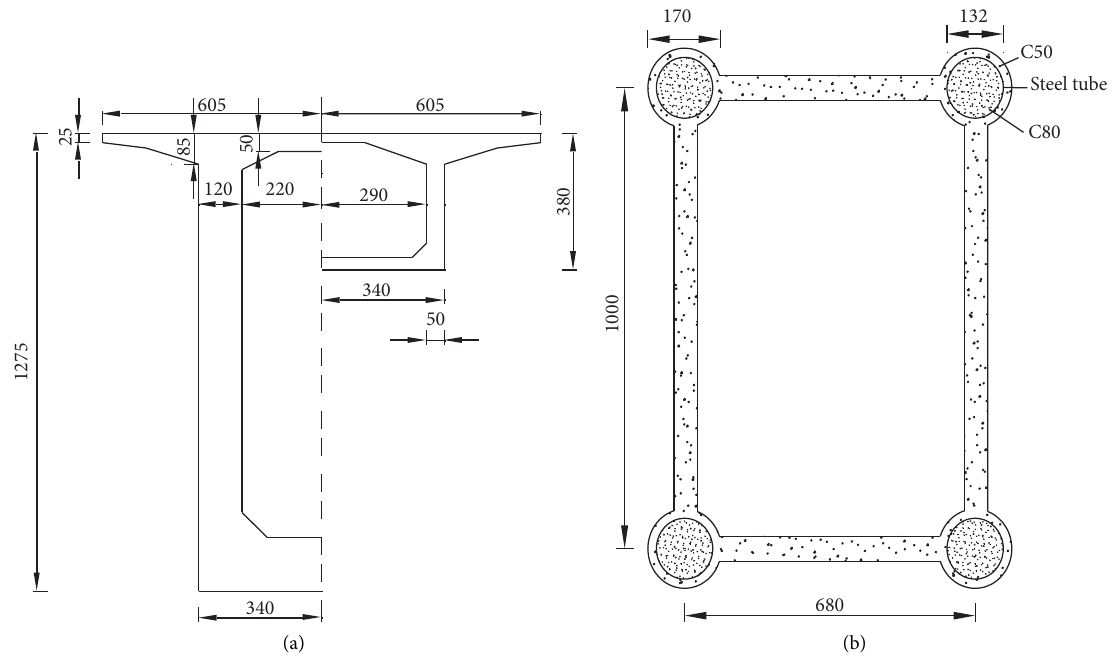
Figure 8: Dimensions of cross-sections of Labajin Bridge: (a) girders; (b)